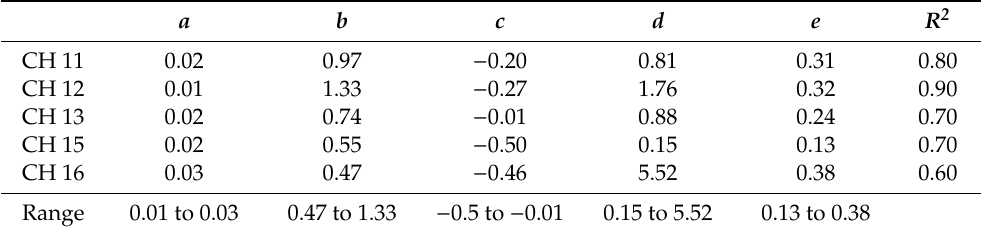
Table 6. Coe ffi cients used in the prediction of d max for each channel with Equation